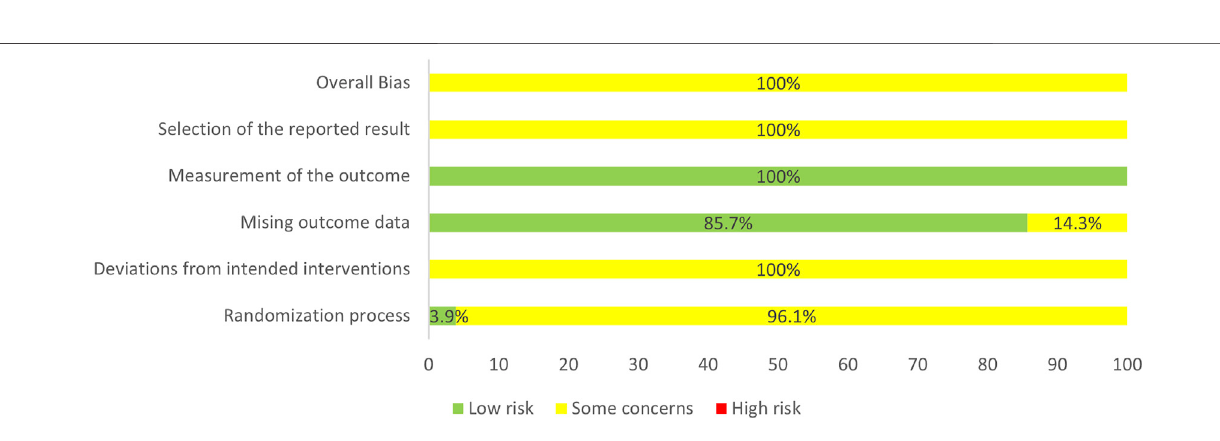
FIGURE 3 | Assessment of risk